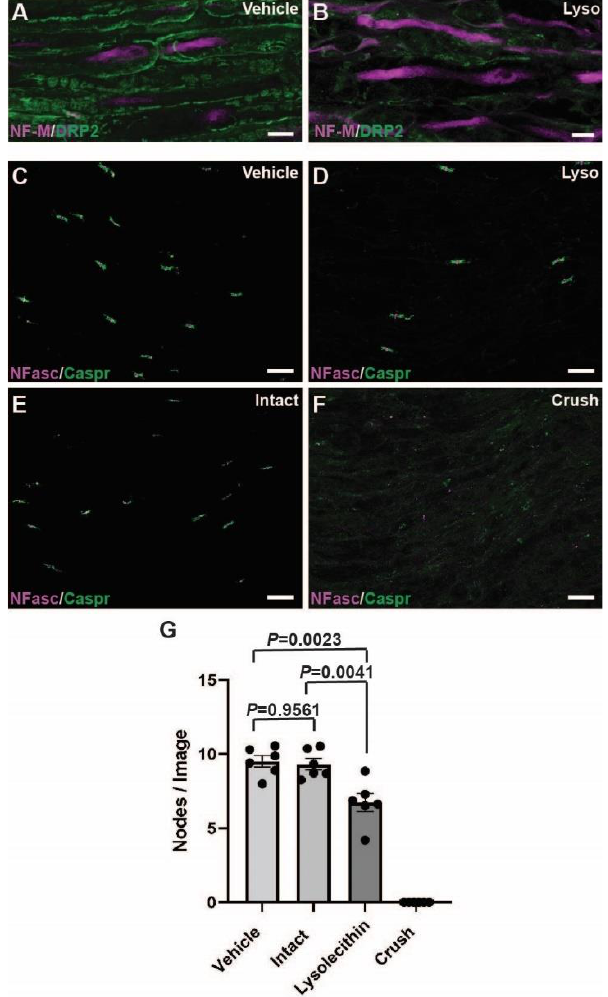
Figure 4. Changes in myelinated nerve fibers after intraneural lysolecithin injection or sciatic nerve crush. ( A , B ) Immunostaining of rat peroneal nerve sections at a vehicle injection ( A ) or lysolecithin injection ( B ) (6 days after injection). Loss of dystrophin-related protein 2 (DRP2) staining (green) in ( B ) demonstrates the loss of myelin sheaths, while the preserved neurofilament (NF)-M staining (violet) shows preserved axons. Loss of DRP2 staining was observed in sciatic nerve sections of all 6 rats used for lysolecithin injections. Scale bars = 10 µ m ( A , B ). ( C – F ) Representative images of immunostaining of rat tibial nerve sections: 6 days after vehicle ( C ) or lysolecithin ( D ) injection, intact nerve ( E ), or 6 days after a crush injury ( F ). Lysolecithin-injected and contralateral intact samples were obtained from the same animals. Tibial nerves were sectioned between the knee and ankle, distal to the site of injections or crush. Structures of nodes of Ranvier were stained with neurofascin (NFasc, violet) and Caspr (green). Anti-neurofascin antibody used in this immunofluorescence strongly reacts to neurofascin 186 at nodal axolemma, and weakly reacts to neurofascin 155 at paranodes and Schmidt-Lanterman incisures in Schwann cells. Note a total disruption of nodes and paranodes after crush injury ( F ). Scale bars = 20 µ m ( C – F ). ( G ) Quantification of nodes of Ranvier density per field of view (224 µ m × 168 µ m) in tibial nerves distal to site of injection or crush (panels ( C – F )). A 3-group comparison among vehicle-injected nerves, intact nerves, and lysolecithin-injected nerves was performed with one way ANOVA with Tukey’s multiple comparisons test. Mean ± SEM graphed with n = 6 rats. The crush group was not included in statistical analysis as there were no discernible nodes of Ranvier found in the sections from the 6 animals that were analyzed. Detailed results of statistical analyses are provided in the Supplementary Information S3.